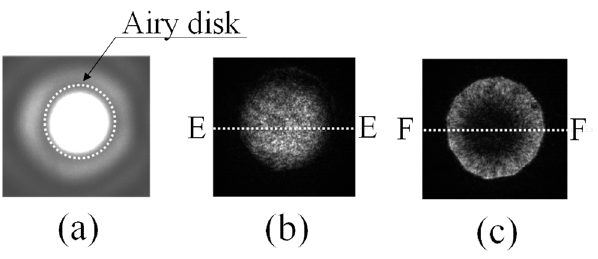
Figure 8. Overlap of di ff racted lights with phase information. ( a ) Di ff racted light source model. ( b ) Overlap of two light sources with phase di ff erence 0 rad. ( c ) Overlap of two light sources with phase di ff erence π rad.